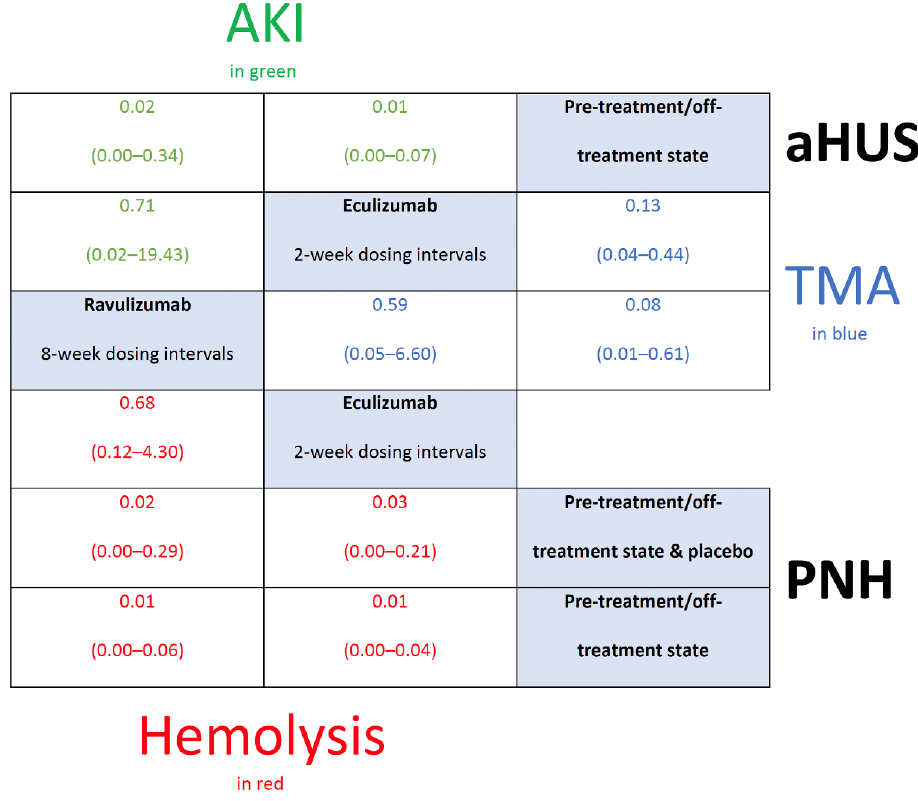
Figure 3. League table showing effect estimates of the assessed complement C5 inhibitors (eculizumab vs. ravulizumab) against the comparators on three outcomes (acute kidney injury (green), thrombotic microangiopathy (blue), and hemolysis (red)) (clinical trials). aHUS, atypical hemolytic uremic syndrome; AKI, acute kidney injury; PNH, paroxysmal nocturnal hemoglobinuria; TMA, thrombotic microangiopathy. Table 3. SUCRA-based ranking of C5 inhibitors evaluated (clinical trials). Drug Intervention † C5 Inhibitors